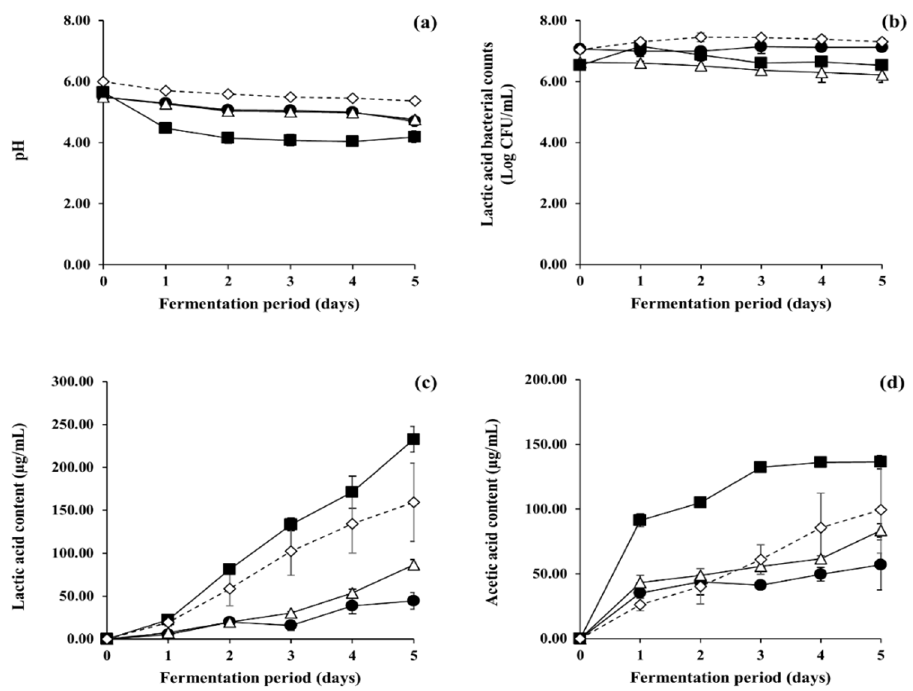
Figure 3. Changes in ( a ) pH, ( b ) lactic acid bacterial counts, ( c ) lactic acid content, and ( d ) acetic acid content of LFG during each step of the optimisation process to enhance the microbial metabolic activity. ● : control (fermentation without supplementation), △ : optimisation step 1 (fermentation with supplementation of 1% fermentation alcohol), ■ : optimisation step 2 (fermentation with sup- plementation of 1% fermentation alcohol and 6% glucose), ◇ : optimisation step 3 (fermentation at 35 °C, ineffective). Fermentation alcohol supplementation was based on a previous article, and the concentration was optimised. Glucose was selected based on the effects of several carbohydrates at the same concentration, and the glucose concentration was subsequently optimised. Fermentation at 35 °C was selected through fermentation tests at several fermentation temperatures, but fermen- tation at 37 °C tested in the previous stage was more effective. So, the results obtained at 35 °C was plotted with dotted line. Error bars indicate standard deviations determined from triplicate experi- ments.